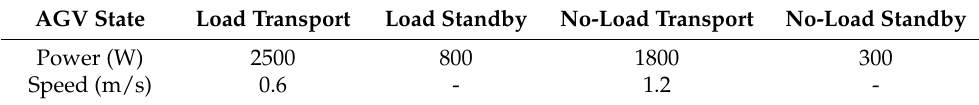
Table 1. AGV data table.